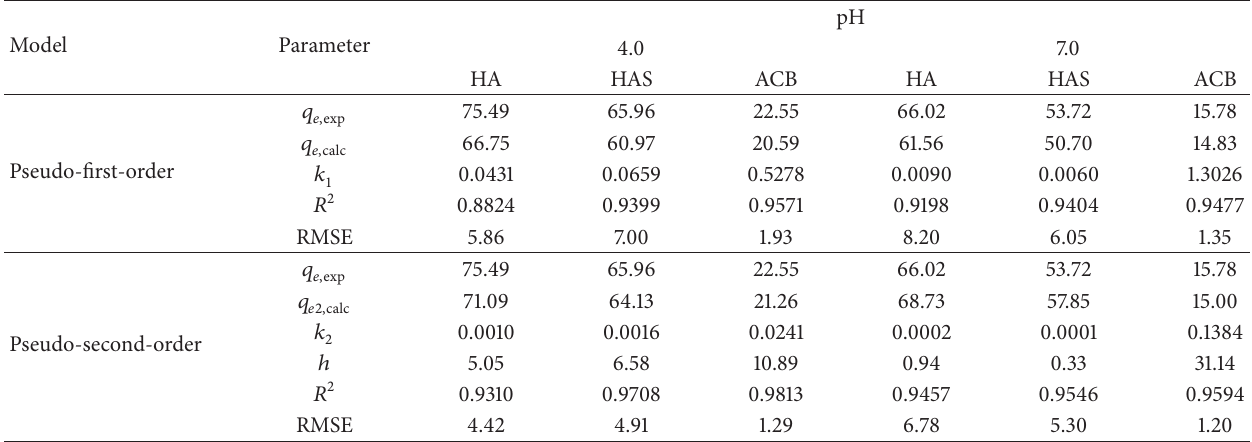
Table 1: Kinetic parameters of BSA adsorption on hydroxyapatite (HA), synthetic hydroxyapatite (HAS), and active babassu coal (ACB) at pH 4.0 and pH 7.0 at 25 ∘ C.